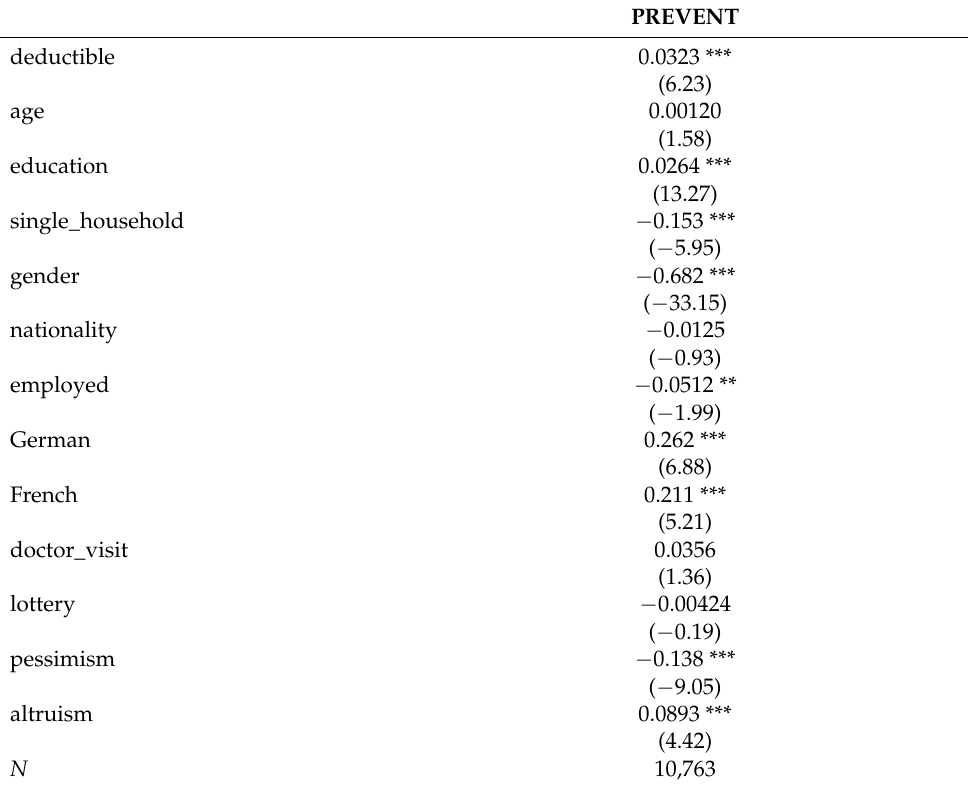
Table 6. Principal component